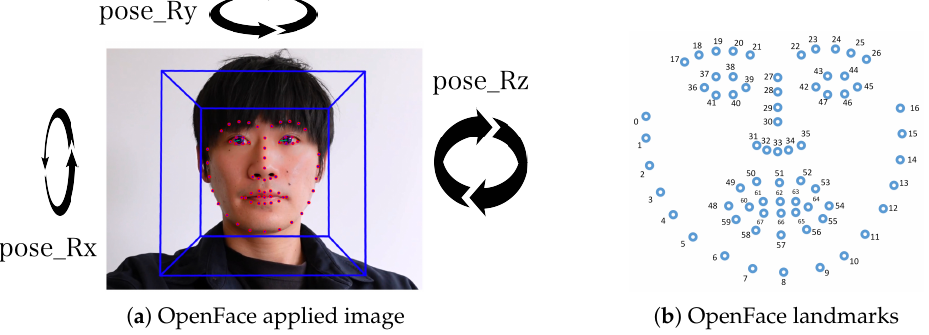
Figure 5. Image after applying OpenFace [44] and the 68 OpenFace landmarks of the facial